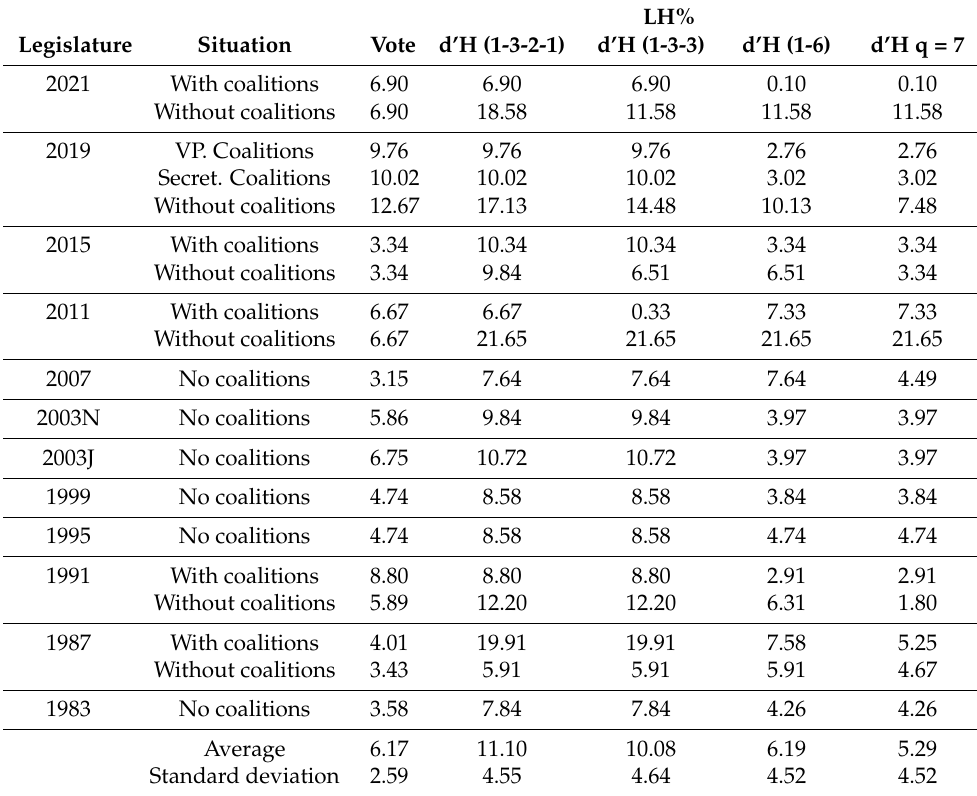
Table 15. The absolute disproportionality index as a function of d’Hondt